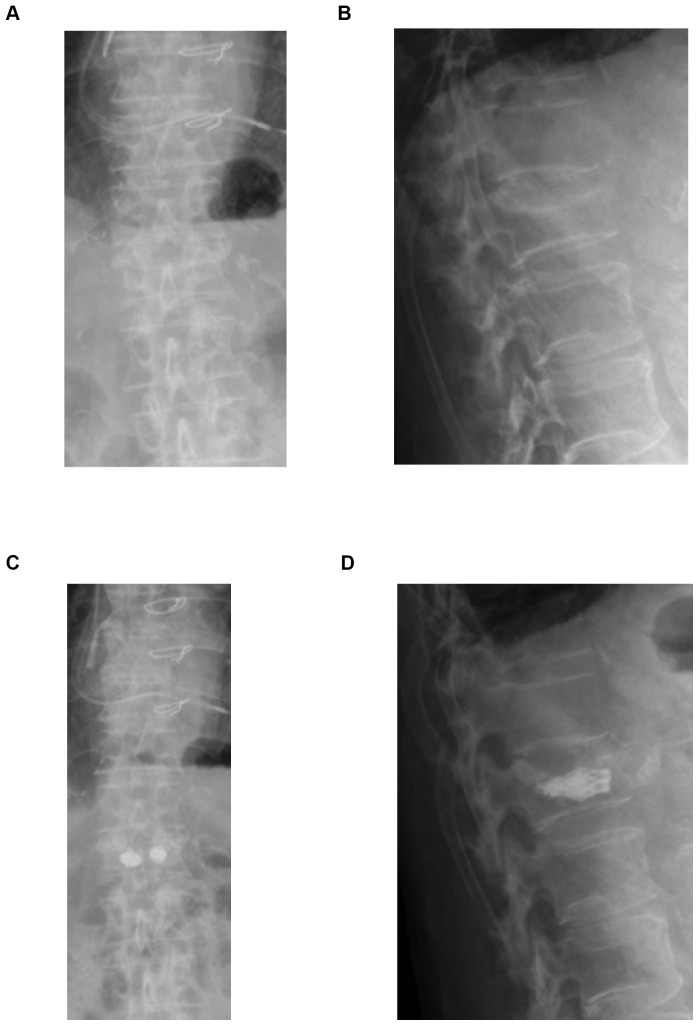
Case presentation with Osseofix® system.(a–d): Radiological case report. Preoperative (a, b) and postoperative (c, d) radiograph of L1 compression fracture and stabilization with Osseofix® system.